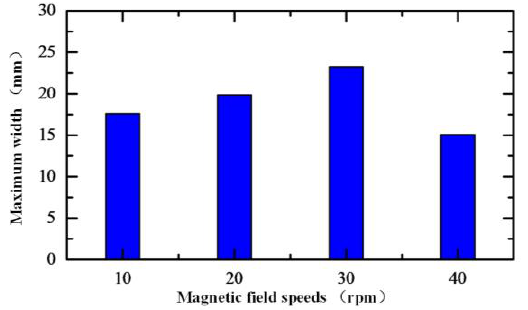
Figure 26. Scratch damage maximum width with different magnetic field speeds.